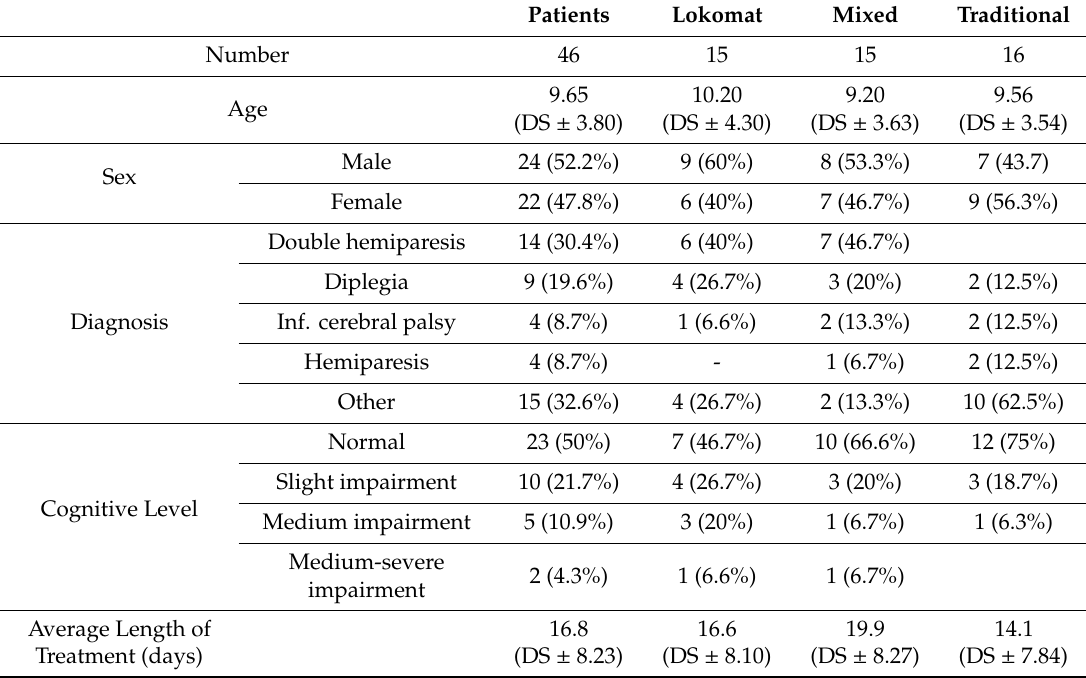
Table 1. Characteristics of the patients enrolled in the study.